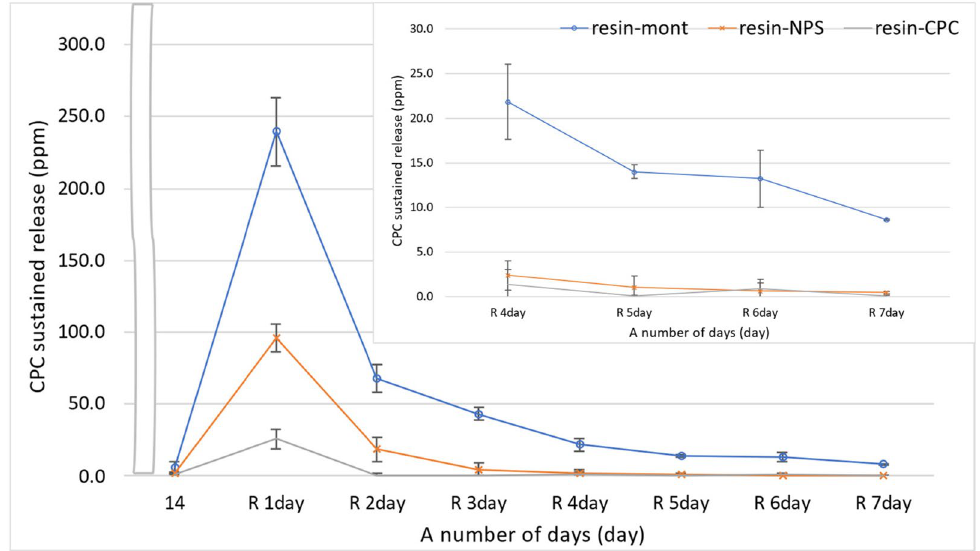
Figure 3. Amount of released CPC from resin-Mont, resin-NPS, and resin-CPC after reuptake. The inside graph is zoomed in on day R 4 through day R 14.